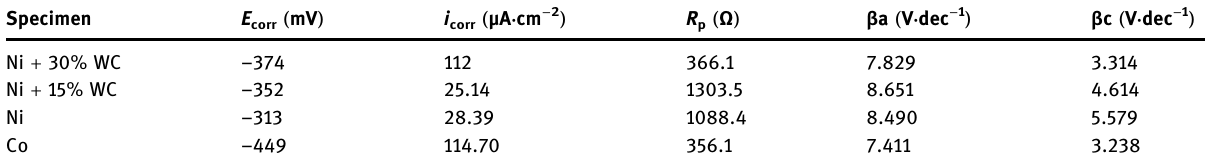
Table 6: Corrosion parameters fi tting results according to the potential dynamic polarization curves in 3.5 wt% NaCl solution for 120 h Specimen